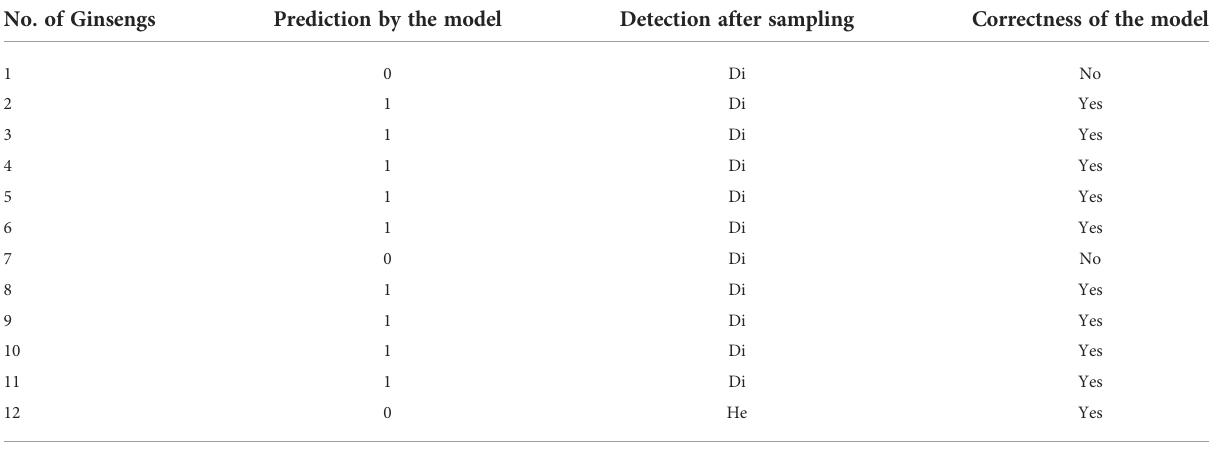
TABLE 2 Root diseases prediction of 12 ginsengs in another plot by the ET